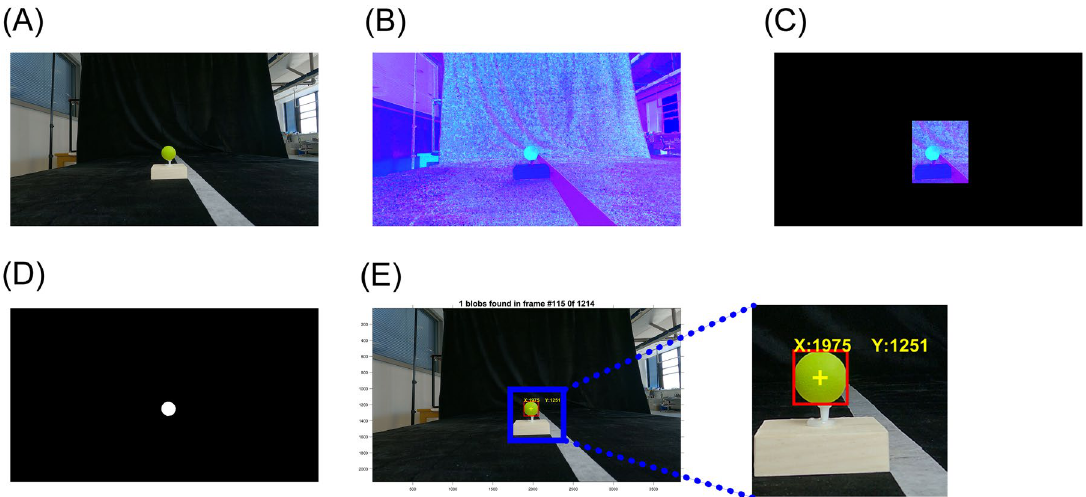
Figure 2. Experiment 1 object detection process. ( A ) Raw image in RGB color space. ( B ) Image in HSV color space. ( C ) Cropped HSV image. ( D ) Binary mask of the target object. ( E ) The final result of the object detection with bounding box (red square) and centroid (yellow cross). The Cartesian coordinate of the centroid is displayed in yellow